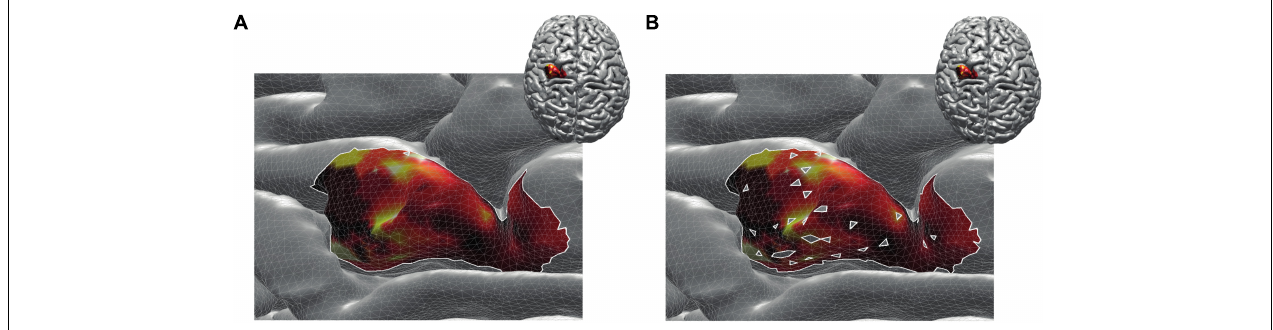
FIGURE 4 | Reconstructed active area in primary motor cortex given a set of stimulation points (orange dots). The color coding indicates the size of the MEP amplitude, with yellow being high and dark red being low. (A) Area without removing the non-MEP points (these points are marked in cyan); (B) area after removing the non-MEP points. By construction, the area shown in (B) is smaller than that in (A) . In both cases, the white lines represent an area’s boundary; note that this boundary does not necessarily equal the area’s convex hull, even when ignoring the non-MEP points (A) .